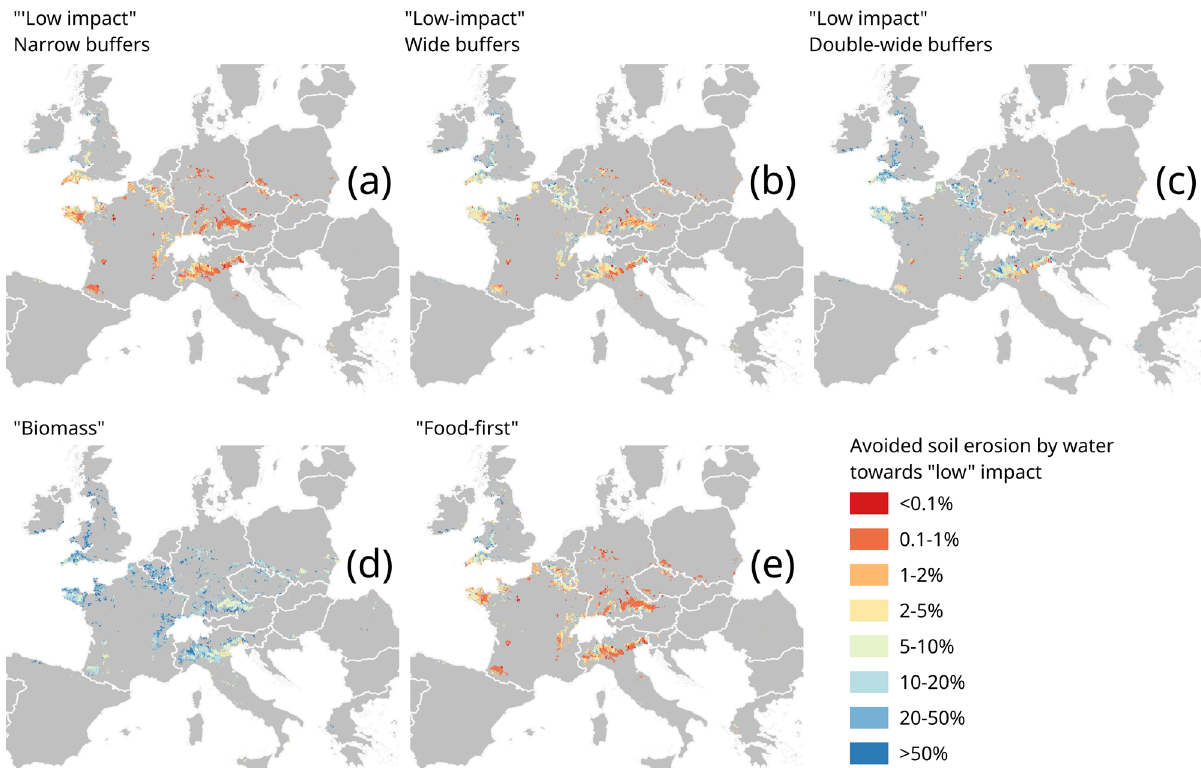
Fig. 3 Avoided soil erosion due to implementation of riparian buffers. Degree to which establishment of riparian buffers contribute towards reducing soil loss by water erosion down to a low-impact level, for the different deployment scenarios ( a – c , d , e ), and different riparian buffer options for the Low-impact scenario ( a – c